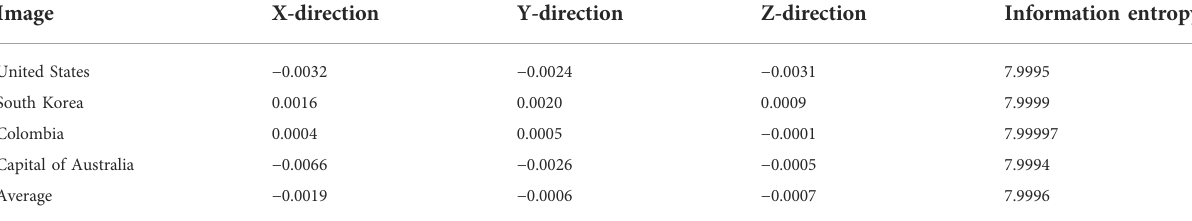
TABLE 8 Replace 1D-SMCLM with logistic map in SMCLM-3ME.